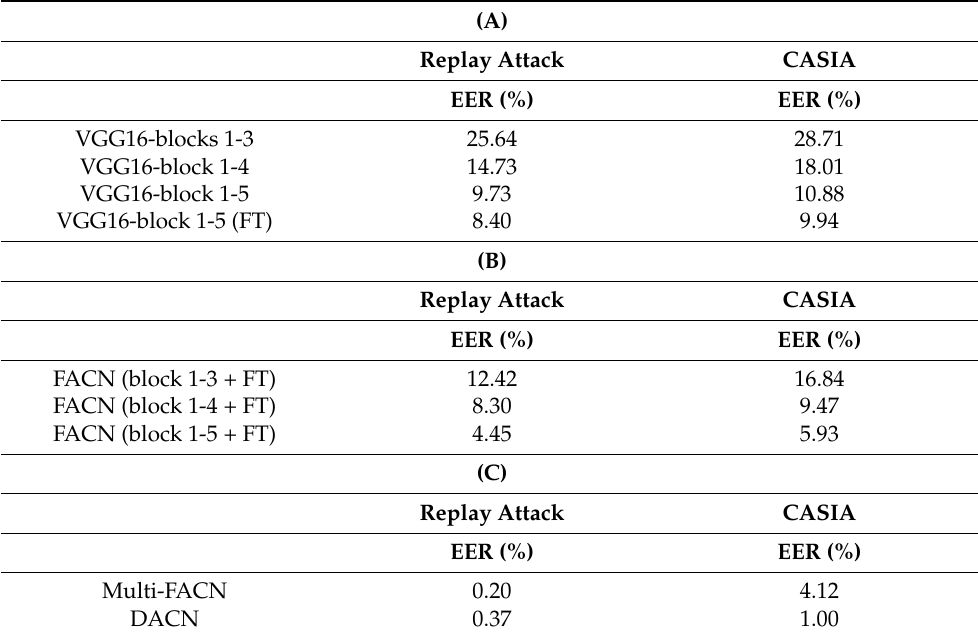
Table 2. ( A ): Baseline Performance with VGG-16. ( B ): Test results with the proposed FACN. ( C ): Test results with/without the temporal